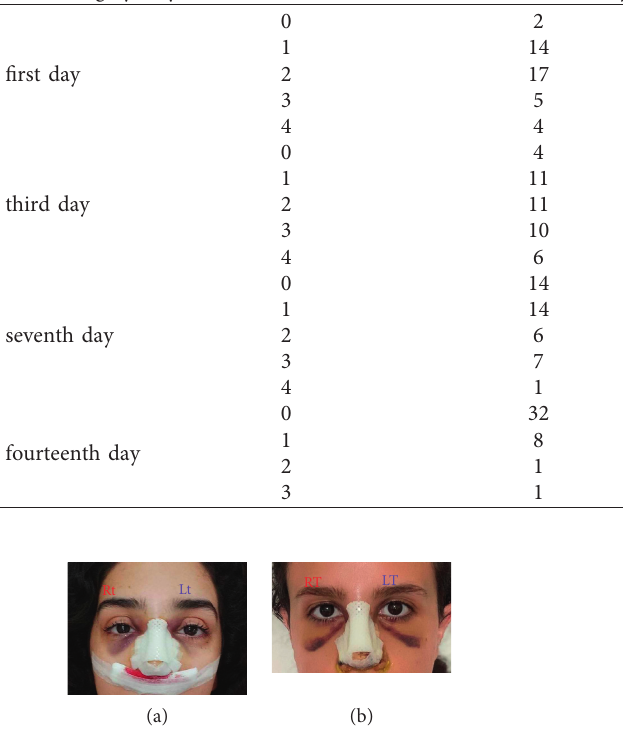
Table 3: Frequency distribution of ecchymosis grade on days 1, 3, 7, and 14 after injection classified into those cases of the patients’ faces that received the injection and those cases of the patients’ faces that did not receive the injection. Time after surgery, day